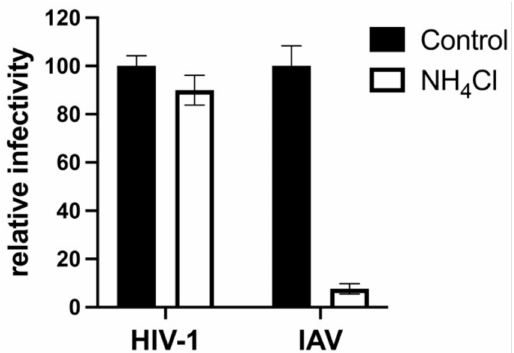
Figure 3. Transduction of TZMbl cells is pH-dependent when vectors are pseudotyped with glyco- protein encoded by IAV but not by HIV-1. HIV-1 virions pseudotyped with glycoproteins encoded by either HIV-1 or IAV H7/N1 were produced by transfection of HEK293 cells. TZMbl cells were then challenged with the pseudotyped vectors, either in the presence of NH4Cl or without. Each condition shows results of vector production from at least three independent transfections.